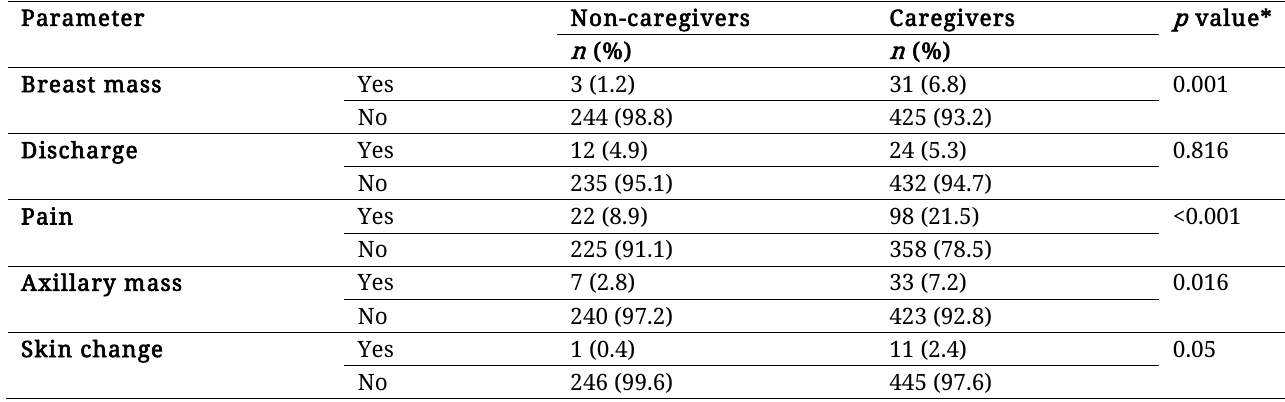
Table 2: Frequency of warning signs of breast cancer reported by non-caregivers and caregivers Parameter